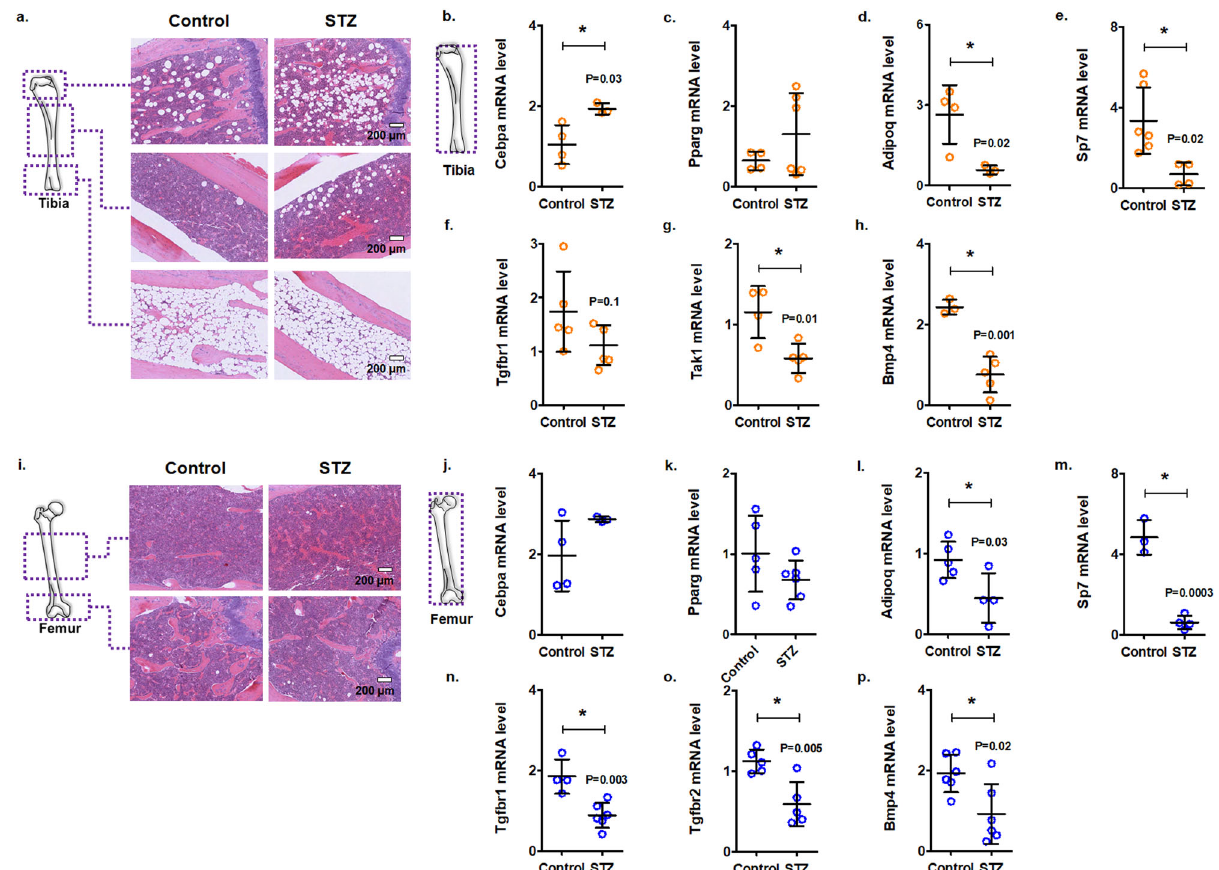
Fig. 4 Enhanced adiposity in tibiae of mice after 2 months of streptozotocin-induced diabetes. C57BL/6 male mice received streptozotocin (STZ; 50 mg/kg) or citrate buffer (non-diabetic controls). Tibiae were harvested 2 months after the onset of diabetes. a Representative H&E-stained sections of the tibia showing proximal, shaft, and distal regions [scale bar = 200 μ m]. mRNA levels of adipogenesis-associated ( b – d ) and osteogenesis-associated ( e ) genes in marrow fl ush samples of mouse tibia [Data normalized to Actb, Atp5f1 , and Pgk1 ; Mean ± SD; n = 4 control and 3 STZ in panel b , 4 control and 6 STZ in panel c , 4 control and 3 STZ in panel d , 6 control and 4 STZ in panel e ; each data point represents a mouse; two-tailed student ’ s t -test: * p < 0.05]. mRNA levels of TGFB pathway genes in the tibiae of control or diabetic (STZ) mice after 2 months of diabetes onset [Data normalized to Actb and Gapdh ; Mean± SD; n = 4 control and 5 STZ in panels f and g , 3 control and 5 STZ in panel h ; each data point represents a mouse; two-tailed student ’ s t -test: * p < 0.05]. i Representative H&E-stained sections of the femur showing shaft and distal regions [scale bar = 200 μ m]. mRNA levels of adipogenesis- associated ( j – l ) and osteogenesis-associated ( m ) genes in marrow fl ush samples of mouse femur [Data normalized to Actb, Atp5f1 , and Pgk1 ; Mean ± SD; n = 4 control and 3 STZ in panel j , 5 control and 6 STZ in panel k , 5 control and 4 STZ in panel l , 3 control and 4 STZ in panel m ; each data point represents a mouse; two-tailed student ’ s t -test: * p < 0.05]. mRNA levels of TGFB pathway genes in the femurs of control or diabetic (STZ) mice after 2 months of diabetes onset [Data normalized to Actb and Gapdh ; Mean ± SD; n = 4 control and 6 STZ in panel n , 5 control and 5 STZ in panel o , 6 control and 6 STZ in panel p ; each data point represents a mouse; two-tailed student ’ s t -test: * p <